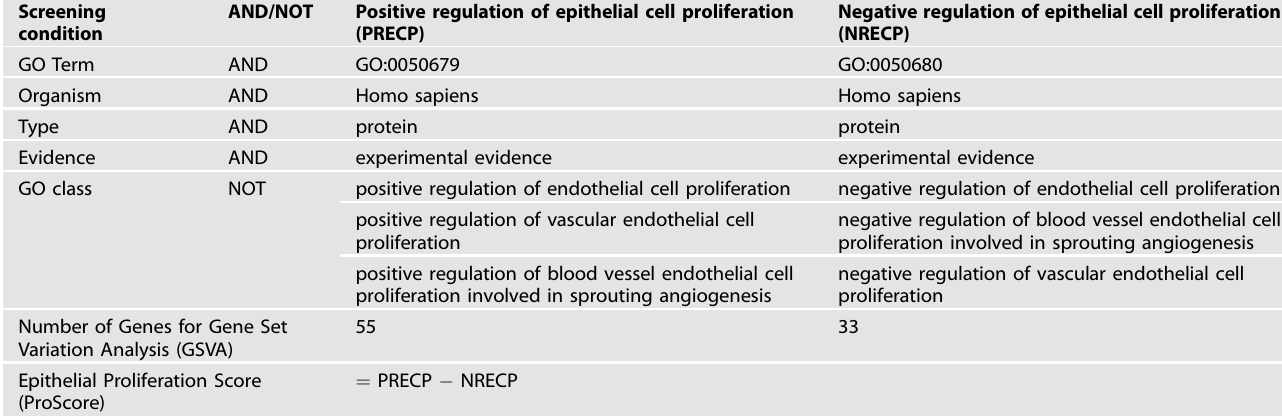
Table 1. Selection of GO terms of Epithelial Proliferation Score